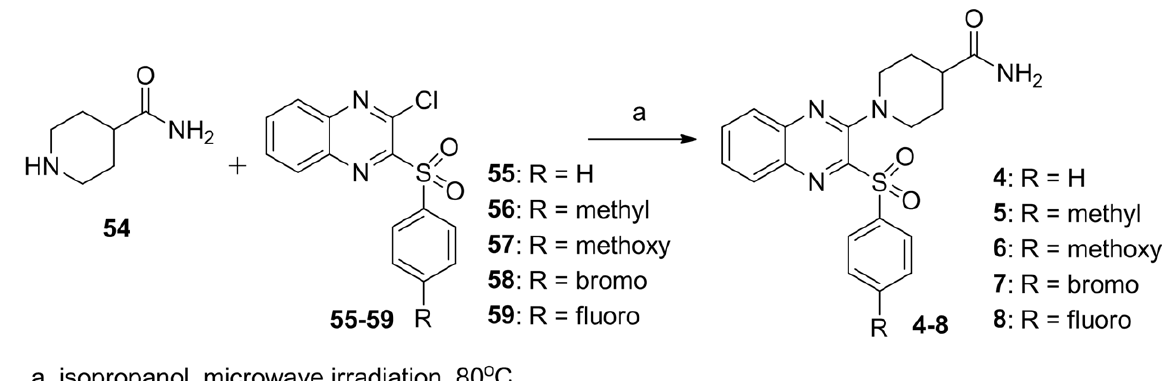
Figure 3. Synthesis of piperidinylquinoxalines 4–8.